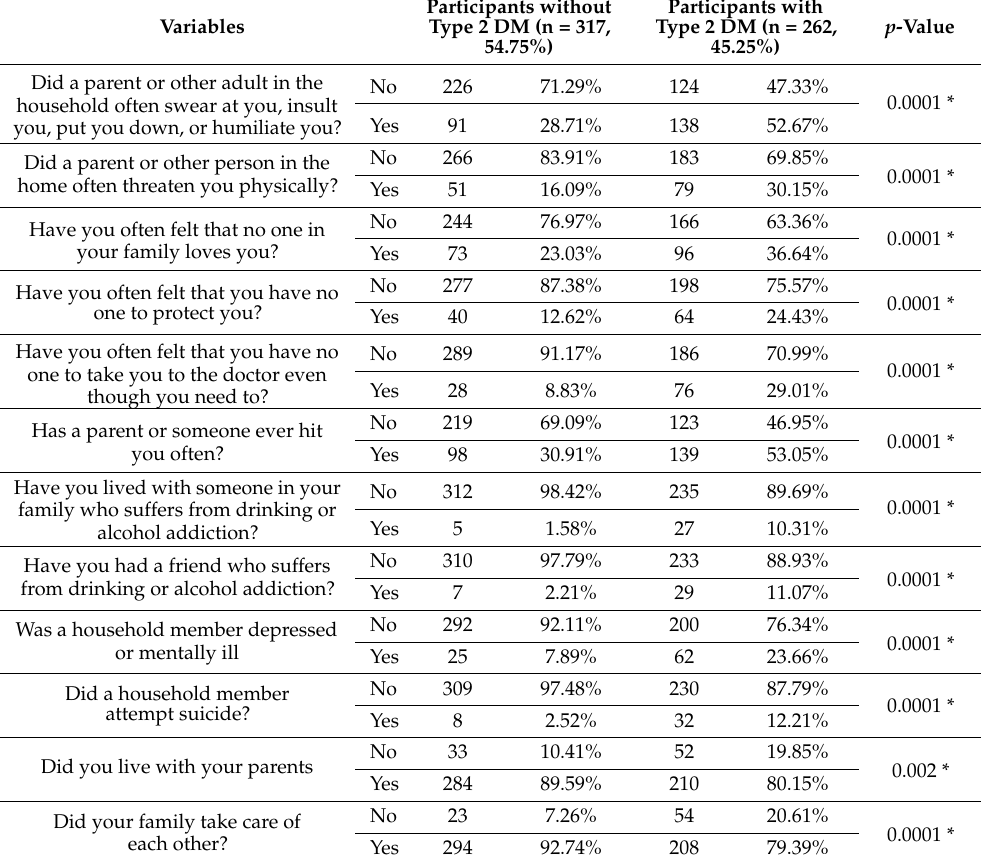
Table 3. Answers of ACE by the participants with type 2 diabetes mellitus compared to those without type 2 diabetes mellitus. Variables